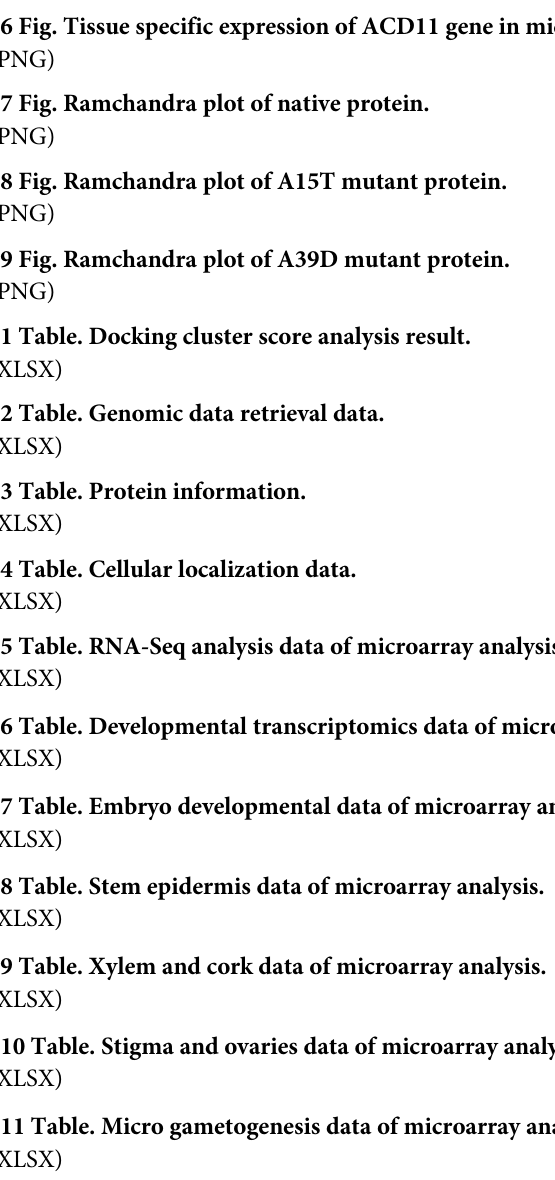
S16 Table. Functional SNP